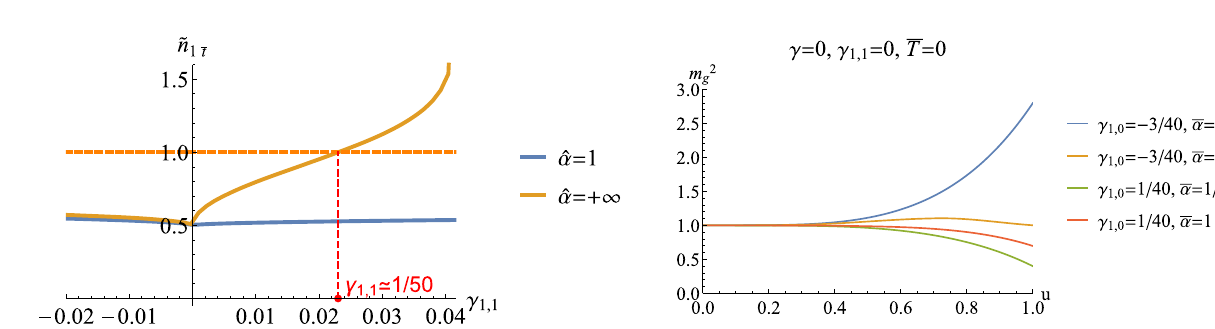
2 g as a function of u at zero temperature for representative and γ 1 , 0 ( γ = 0 and γ 1 , 1 =